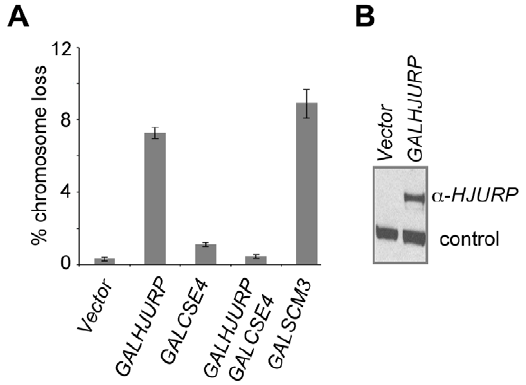
Figure 6. Overexpression of HJURP causes chromosome mis- segregation in budding yeast. (A) Overexpression of HJURP leads to chromosome loss in budding yeast. Reporter strains with chromosome fragment (YPH1018) transformed with a vector (pRS426 GAL1 ), GALHJURP (pMB1490), GALCSE4 (pMB1147), GALHJURP , GALCSE4 (pMB1490, pMB1147), and GALSCM3HA (pMB1306) were assayed for chromosome loss as described in Figure 1 (C). (B) Western blot analysis showing galactose induced expression of HJURP . Whole cell